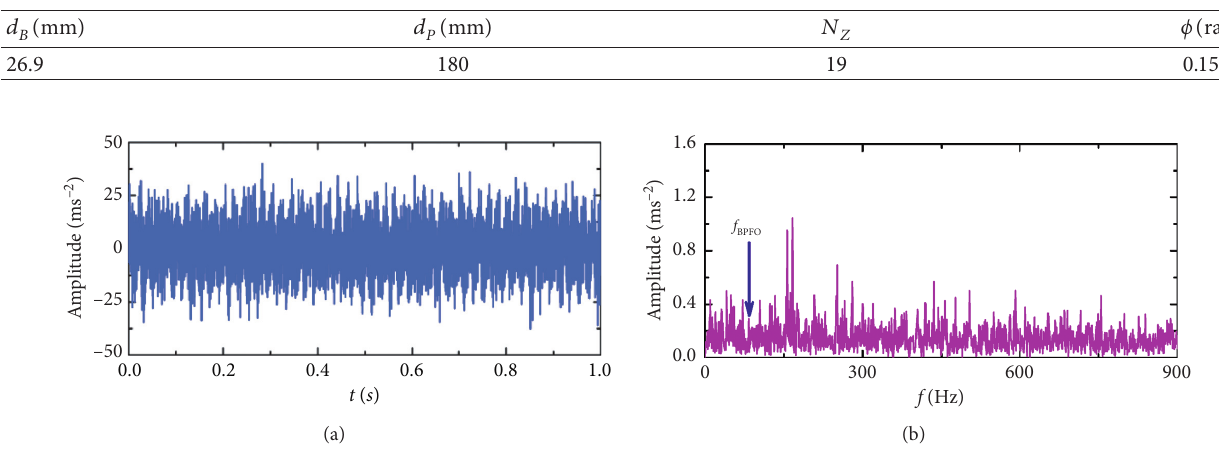
Table 2: Parameters of testing bearing.